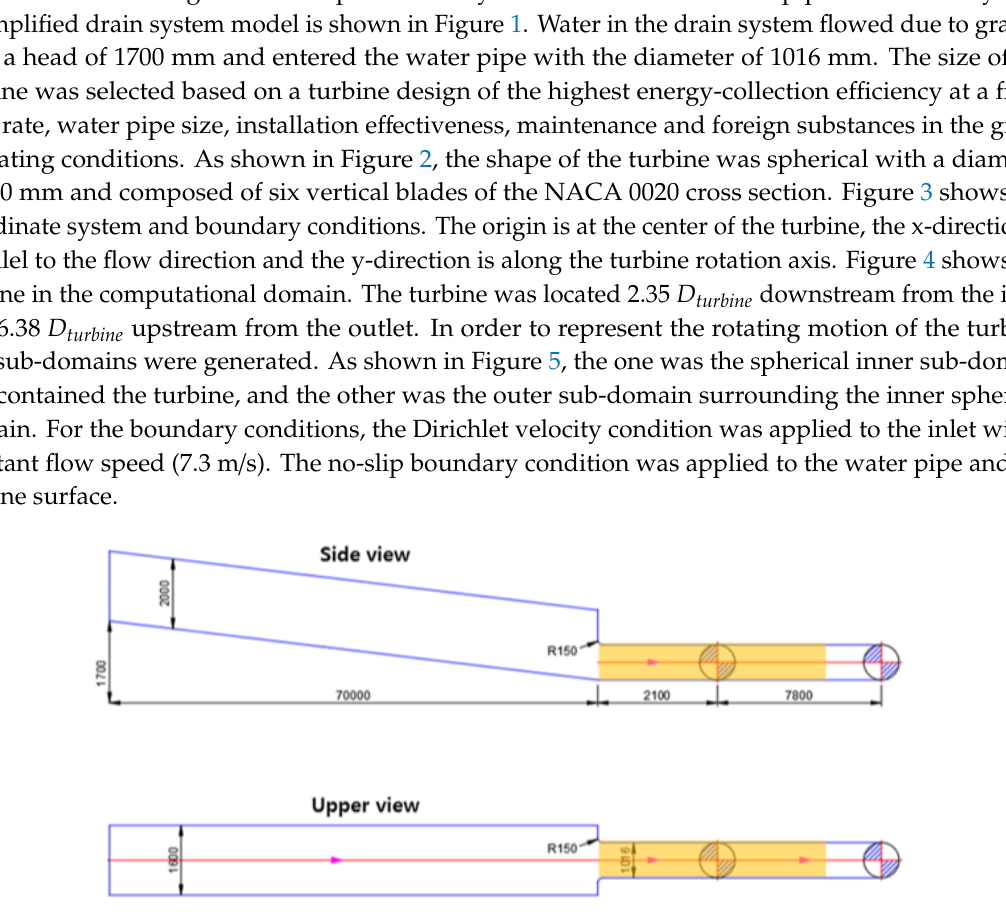
Figure 1. A schematic view of the drain system.